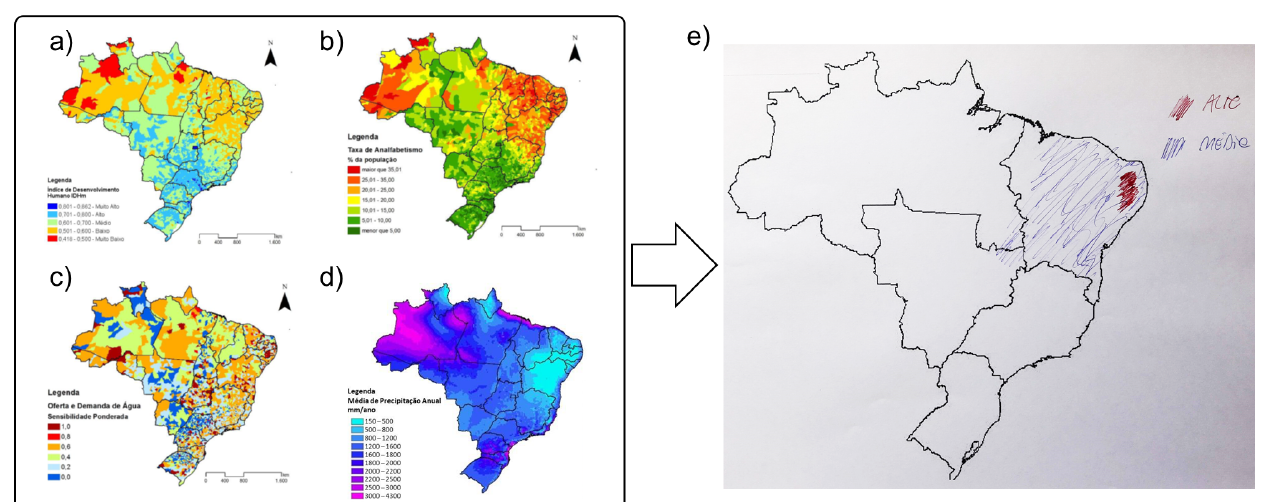
Figure A3. Package of maps used in the first training for mapping climate risk associated with water scarcity. The maps illustrate (a) Hu- man Development Index (HDI; MMA, 2017), (b) illiteracy rate (MMA, 2017), (c) water supply and demand (MMA, 2017), (d) annual precipitation (MMA, 2017), and (e) the climate risk map drawn by the participants.